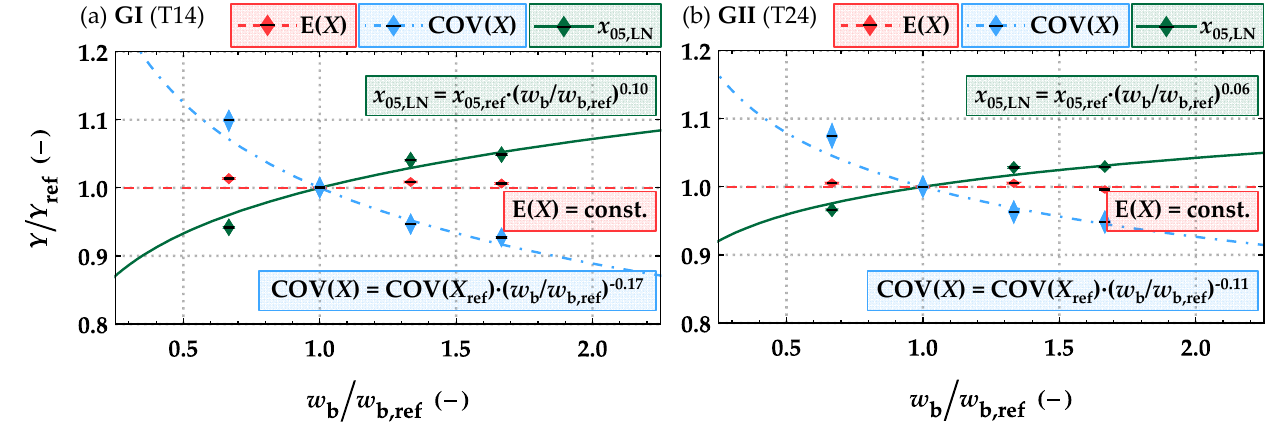
Figure 10. Influence of the width on main statistics Y = {E( X ); COV( X ); x 05,LN } of the tensile strength parallel to the grain of boards ( X = f t,0,b ) at the reference length l ref = 9 × w b relative to the statistics at reference width of w b,ref = 150 mm; analysis based on virtually generated boards for GI ( a ) and GII ( b ). As the reference length according to EN 408 [19] is directly coupled with the width, i.e., l b,ref = 9 × w b , this width effect represents a combined width and length effect. A more